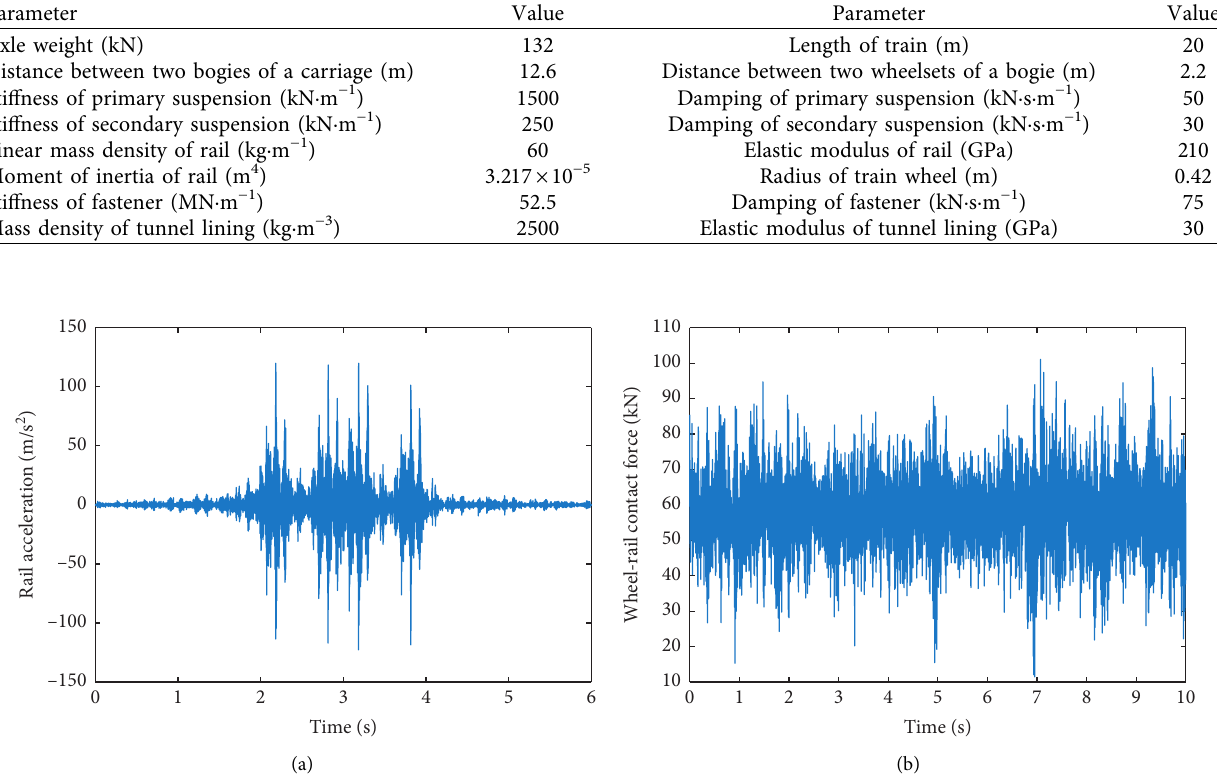
Figure 2: Model of the metro train-monolithic bed track system under tunnel differential settlement. Table 1: Parameters of the metro train-monolithic track system in [19].